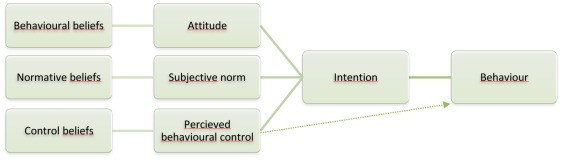
Model of the theory of planned behaviour by Ajzen 1991.